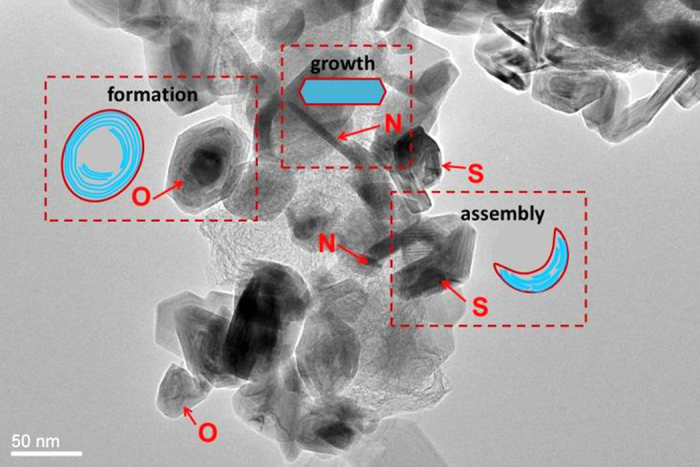
HRTEM image of MoS2 particles: (N) needle-like, (O) onion-like and (S) irregular shaped particles.